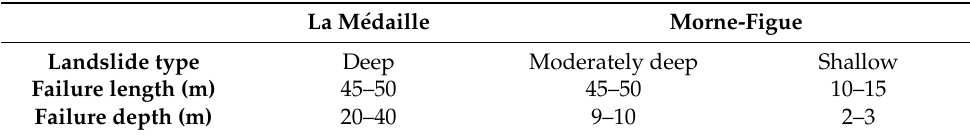
Table 2. Landslide characteristics used for modeling.